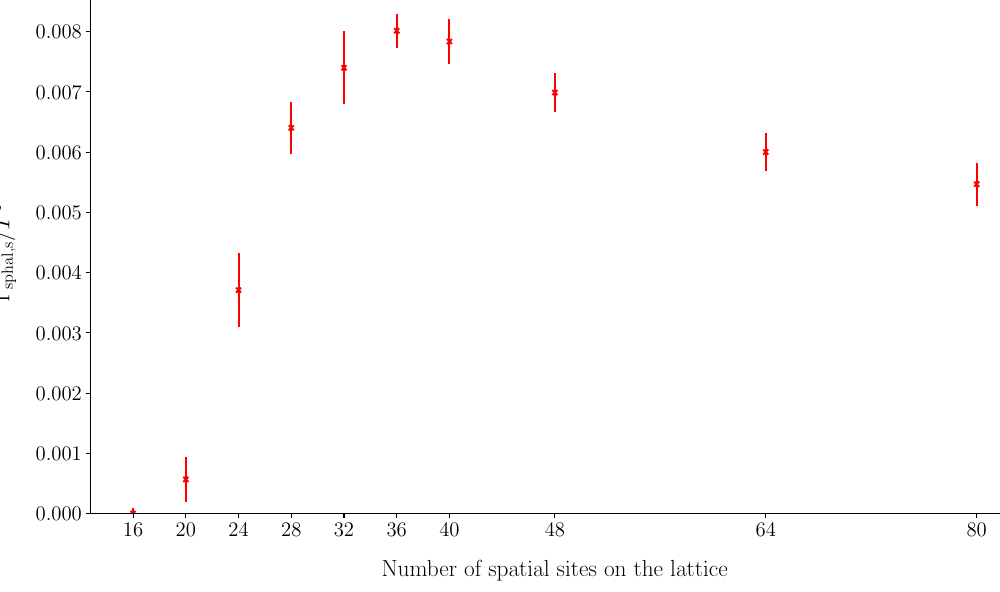
Figure 10 . Sphaleron rate as a function of the aspect ratio N s /N t , at fixed N t and